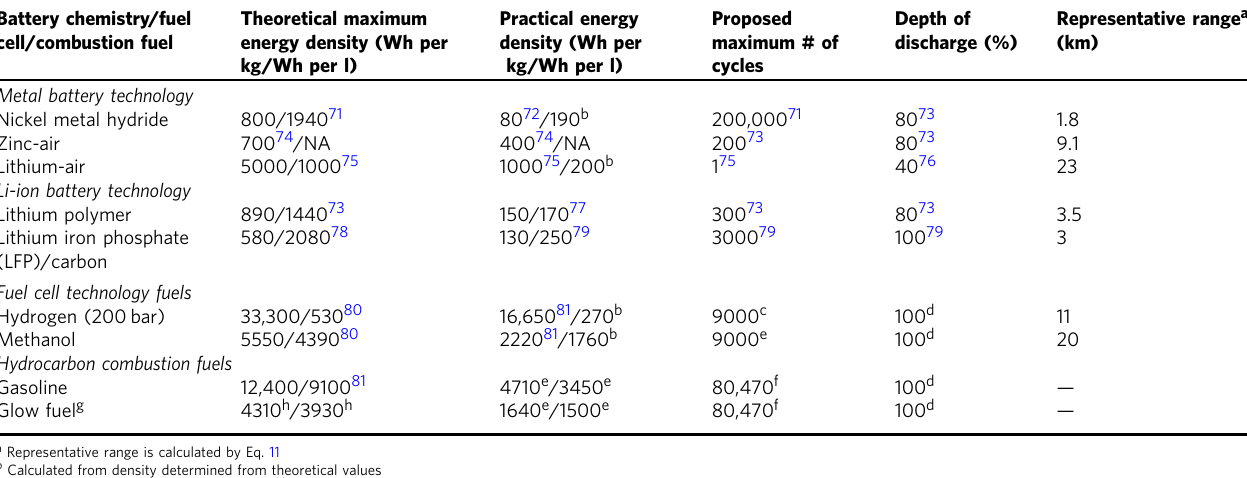
Table 1 Key characteristics of potential energy storage technologies for drones Battery chemistry/fuel cell/combustion